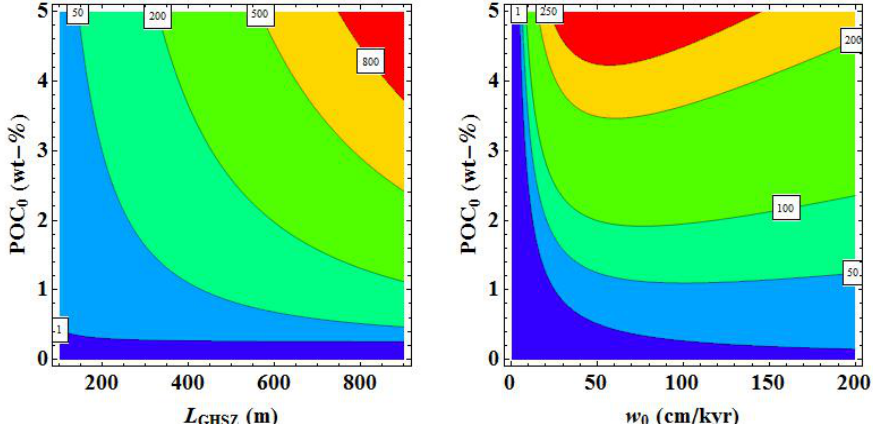
Figure 24. Controls on gas hydrate accumulation as predicted by the transfer function for margin sediments subject to complete compaction. The contour lines indicate gas hydrate inventories (GHI) in kg C m − 2 . The contour plot on the left hand side is calculated for w = 100 cm kyr − 1 while the contour plot on the right shows the results for L 0